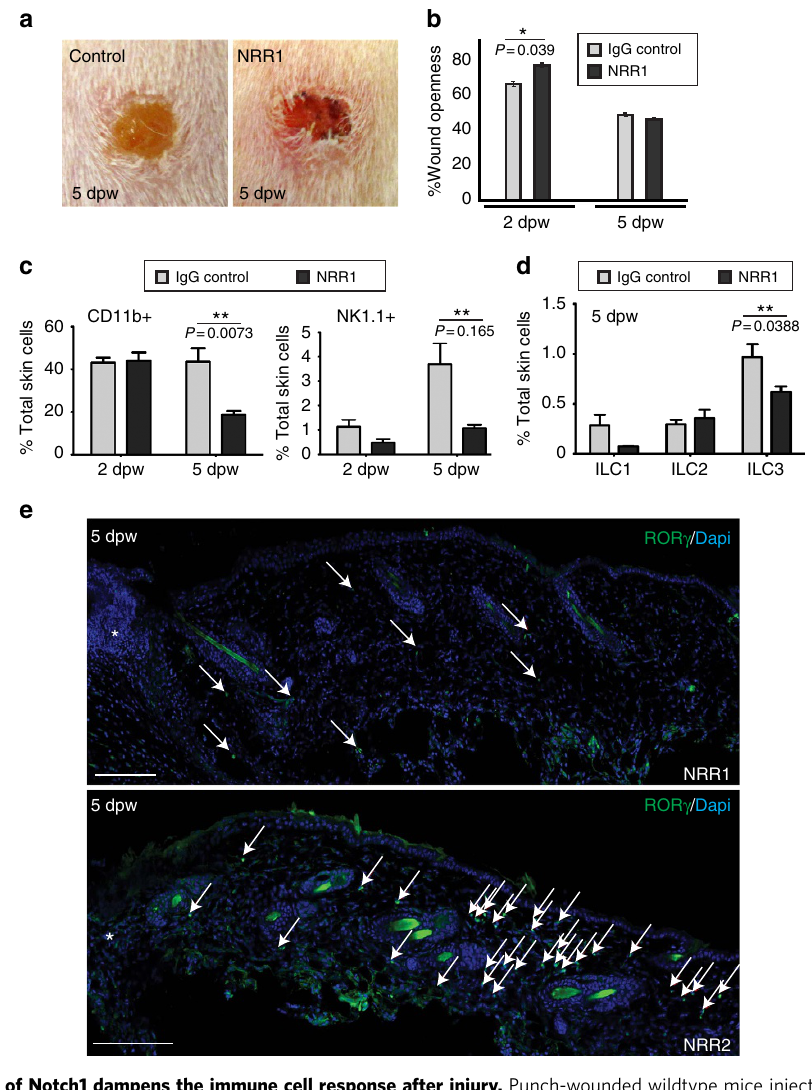
Figure 4 | NRR1 inhibition of Notch1 dampens the immune cell response after injury. Punch-wounded wildtype mice injected i.p. with 5mgkg (cid:3) 1 NRR1 ( a – e ), NRR2 ( e ) or IgG isotype control ( a – d ) antibodies for 7days before injury. ( b ) Wound openness was measured as a per cent of initial wound size at